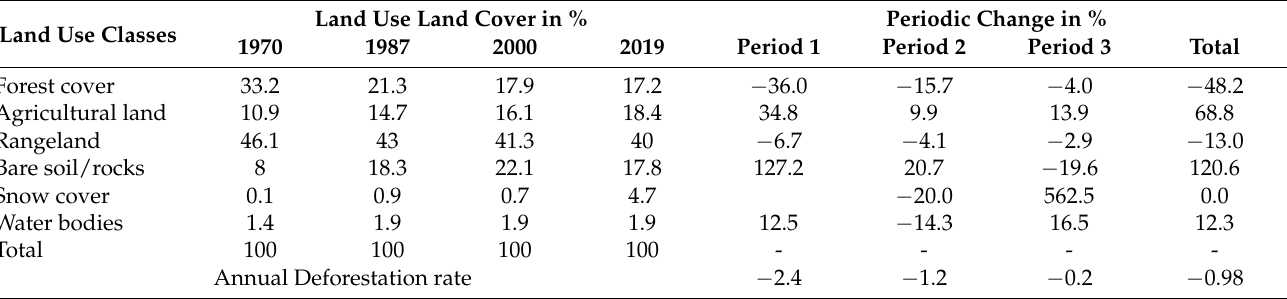
Table 1. Land use/land cover and changes in District Kurram (1972 to